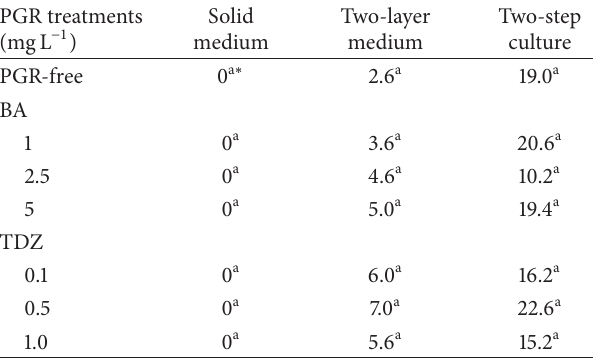
Table3:Numberofembryosformedontheleafsurfaceof2-month- old seedlings, depending on culture systems and concentration of cytokinins.